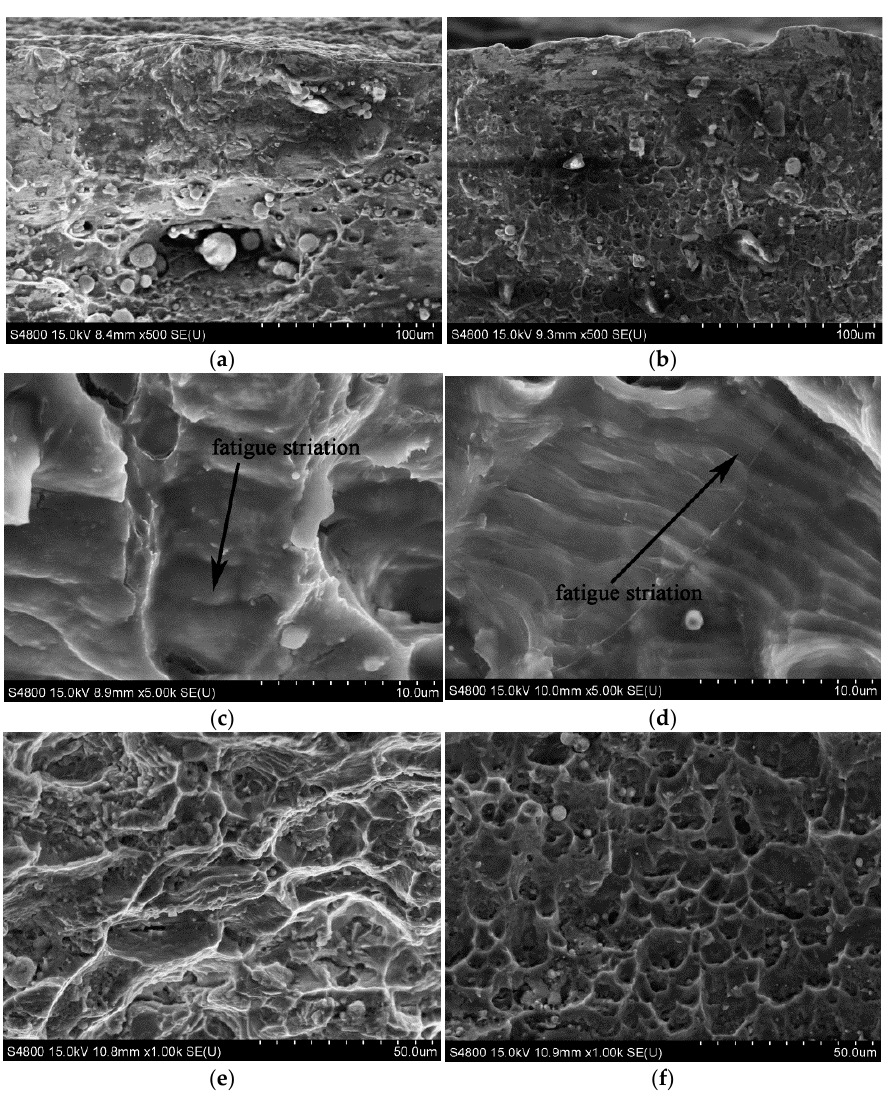
Figure 7. Fatigue fractographs of the specimens with LSP assisted by DSA and untreated: ( a ) crack initiation of the untreated specimen; ( b ) crack initiation of the specimen with LSP assisted by DSA; ( c ) crack growth region of the untreated specimen; ( d ) crack growth region of the specimen with LSP assisted by DSA; ( e ) ultimate fracture region of the untreated specimen; ( f ) ultimate fracture region of the specimen treated with LSP assisted by DSA.